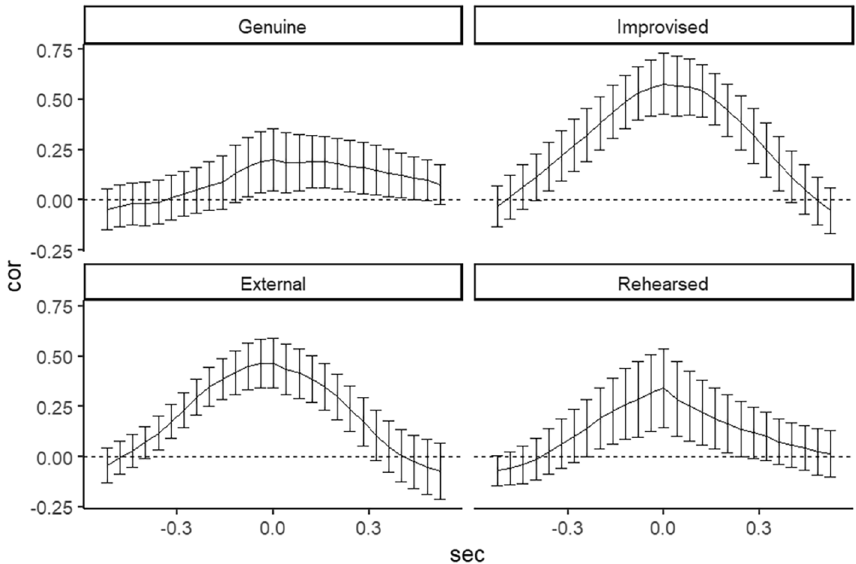
Figure 5. The cross-correlations between the left eyebrow and left eyelid for the four conditions. Error bar represents 95% Confidence Intervals.